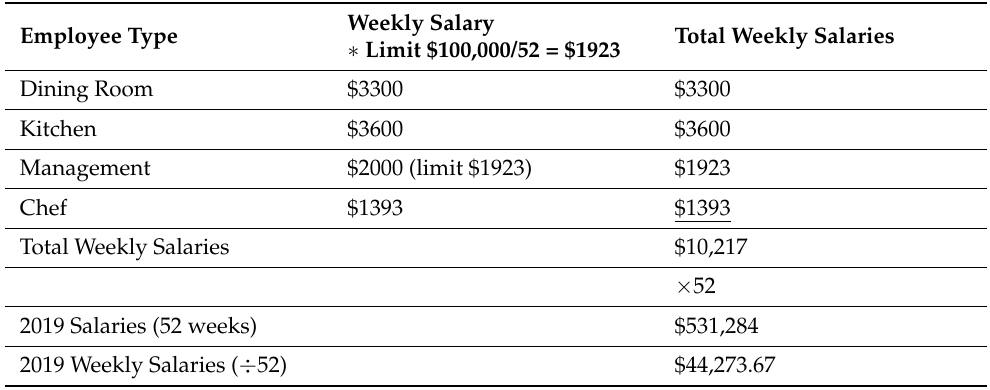
Table 5. Impact of PPP on labor costs. These are a composite of the sales statistics of 3 actual restaurants located in Long Island, New